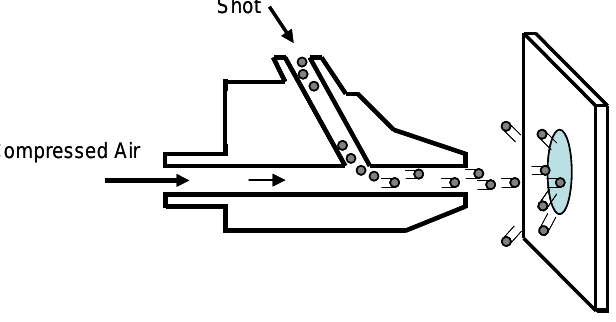
Figure 3: Schematic illustration showing the equipment of ABSP.